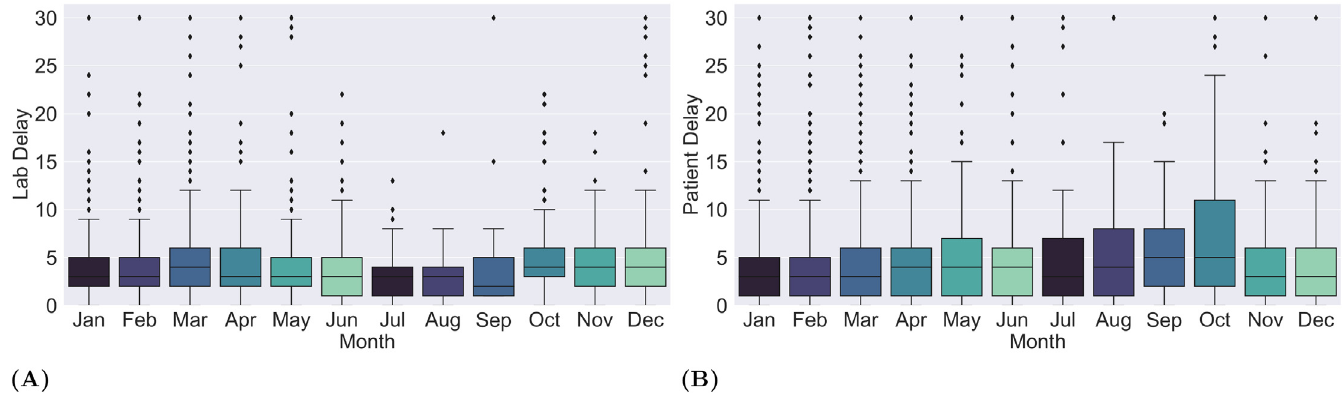
Fig 6. Impact of seasonality on lab and patient delays. The box and whisker plots depict monthly statistics of the lab (A) and patient (B) delays where cases are grouped by month of occurrence.